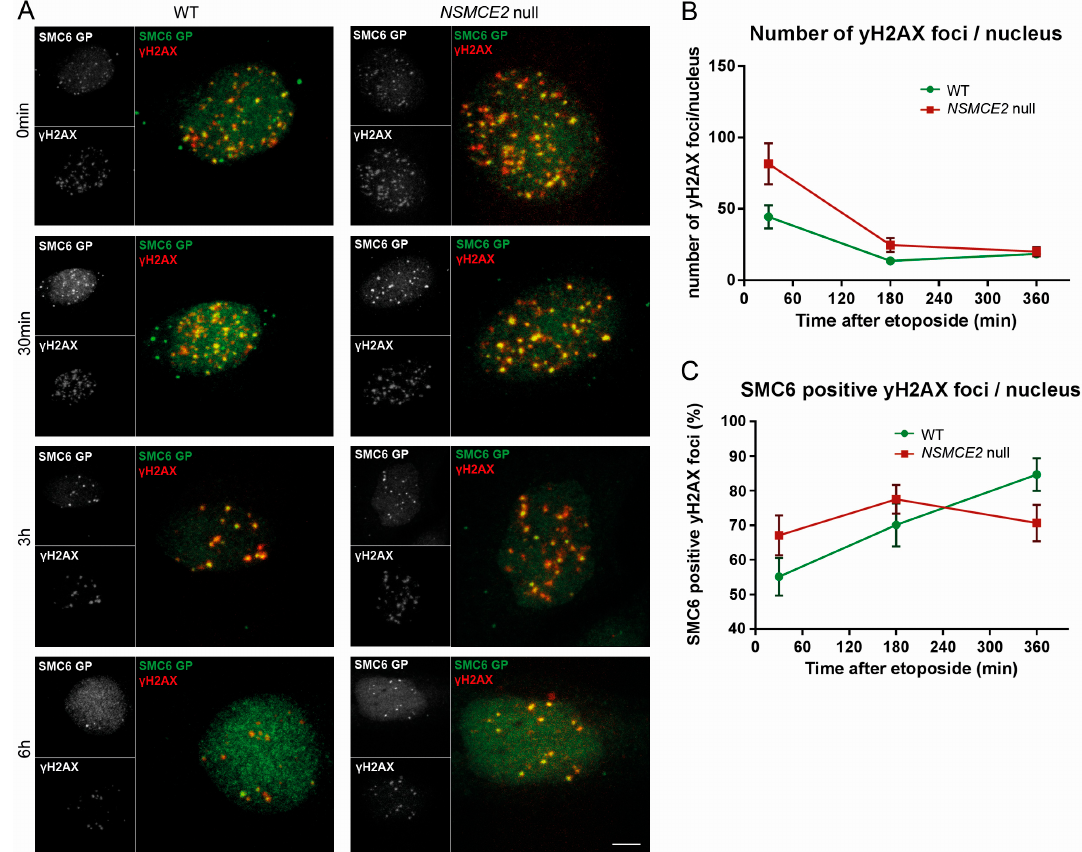
Figure 4. Etoposide ‐ induced DSB foci formation in the absence of NSMCE2. ( A ) WT and NSMCE2 null cells were subjected to 3 µ M etoposide for 1 h, fixed at different time points post treatment (0 min: immediately after etoposide treatment) and stained for γ H2AX (a marker for DNA damage, red) and SMC6 (green). SMC6 localized to sites of DNA damage in both WT and NSMCE2 null cells. Bar = 5 µ m; ( B ) Quantification of the average number of γ H2AX foci in each cell. Significantly more γ H2AX foci were formed in NSMCE2 null cells. Data are presented as mean ± SEM, n = 3; ( C ) Quantification of the average number of γ H2AX foci that overlap with a SMC6 focus. Data are presented as mean ± SEM, n = 3.